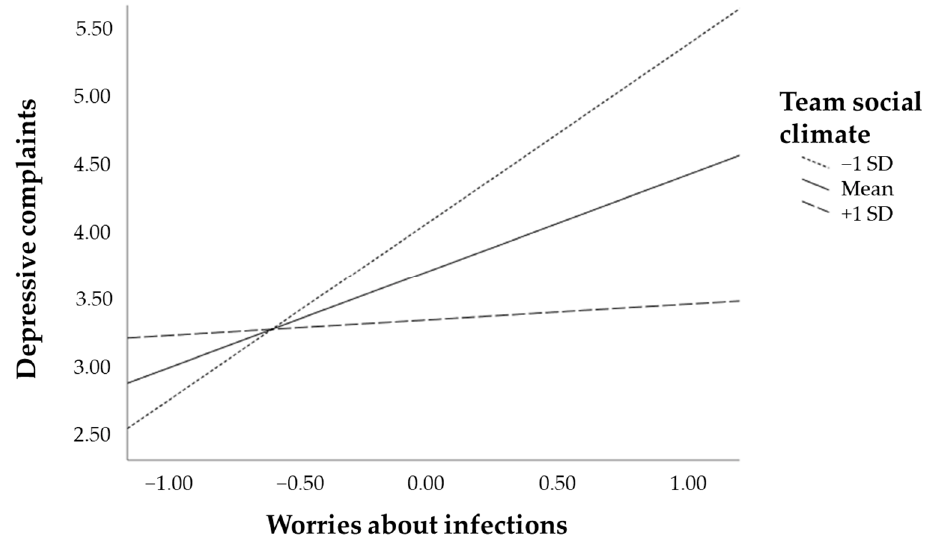
Figure 2. Simple slopes plot for mediated personal resilience on depressive complaints, via worries about infections for the mean, one standard deviation above, and one standard deviation below the mean of team social climate.